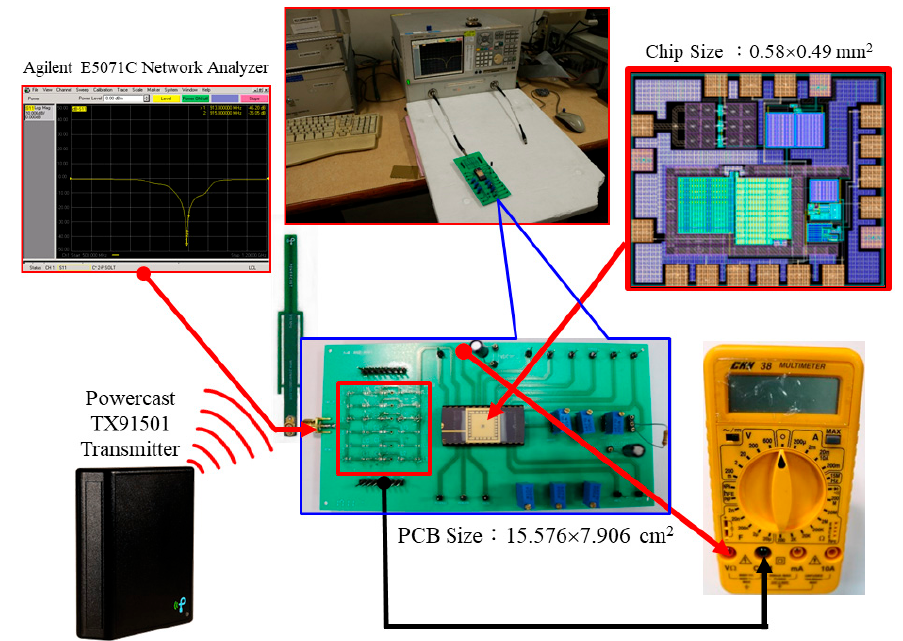
Figure 19. Measurement platform of the designed RF-energy-harvesting IC with capacitor.